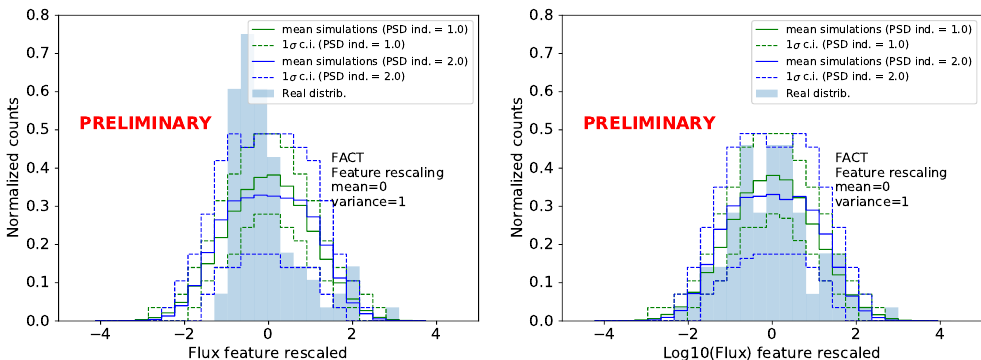
Figure 3. Energy flux distribution of the FACT night-wise light curve compared with estimates from Gaussian ( left panel , 5000 simulations) and log-normal ( right panel , 1000 simulations) simulations. The colour codes are the same as in Figure 2. In this case, the flux distribution is better reproduced using a log-normal simulated dataset.